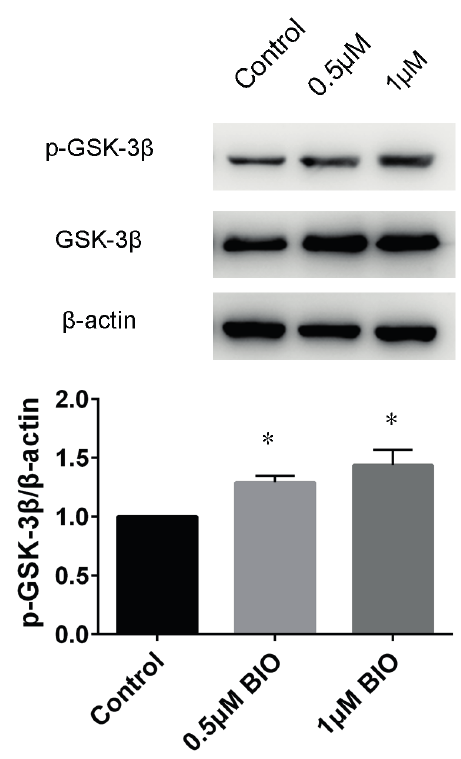
Figure 5 - BIO enhanced the phosphorylation of GSK3β in canine BMSCs. Canine BMSCs were incubated with osteogenic medium with or without BIO for 6 hours, detected expression of phosphorylation of GSK3β by Western blot. (n = 3). The gel Pro Software (Tanon Science & Technology Co., ltd., China) was used to determine the gray values of the internal reference (β-actin) proteins and p-GSK3β protein bands, and the ratios were used as the relative expression of proteins. Calculating p-GSK3β relative expression and averaging. Error bars denote mean ± SD. *P < 0.05. Control: osteogenic medium; 0.5 and 1.0 μM BIO: osteogenic medium containing 0.5 and 1.0 μM